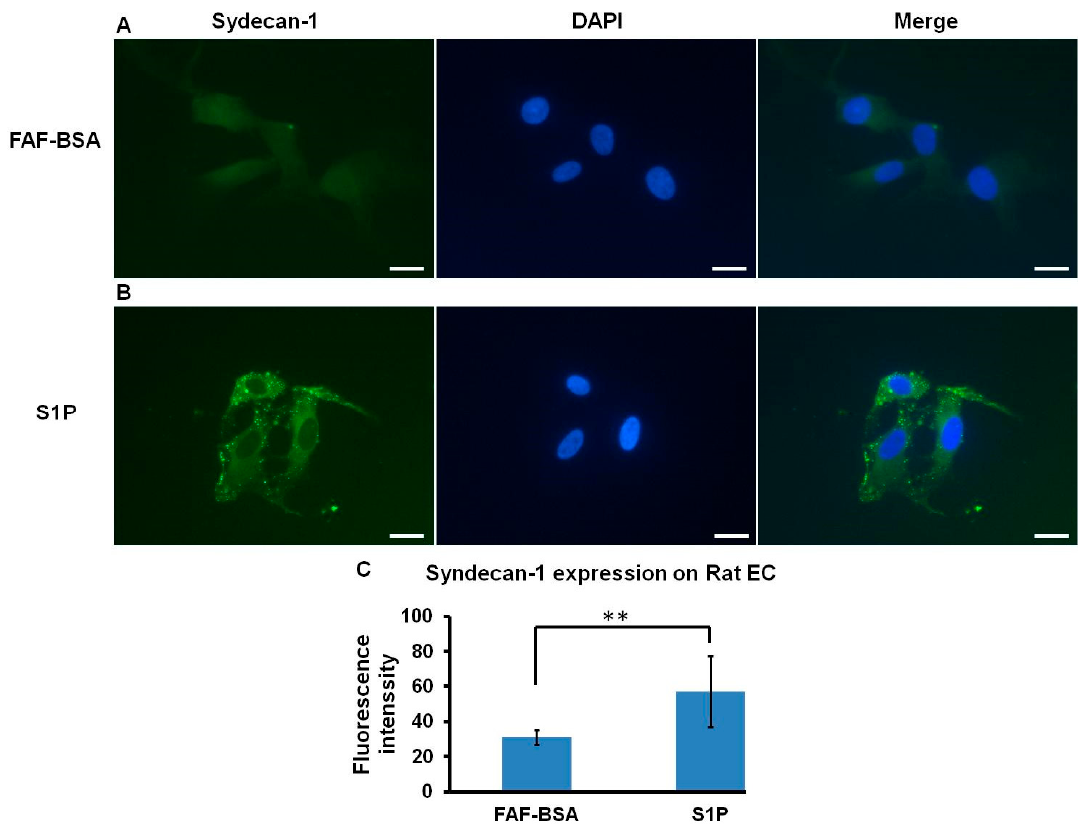
Figure 3. Syndecan-1 expression on rat ECs treated with S1P. In ECs treated with 1 µ M S1P ( Panel B ), the expression of Syndecan-1 increased relative to that of FAF-BSA vehicle control ( Panel A ) (Left column: syndecan-1, middle column: DAPI, right column: merge; Magnification, 400×; scale bar = 50 µm); Panel C , Fluorescence intensity of syndecan-1 expression on rat ECs. ** p< 0.01.